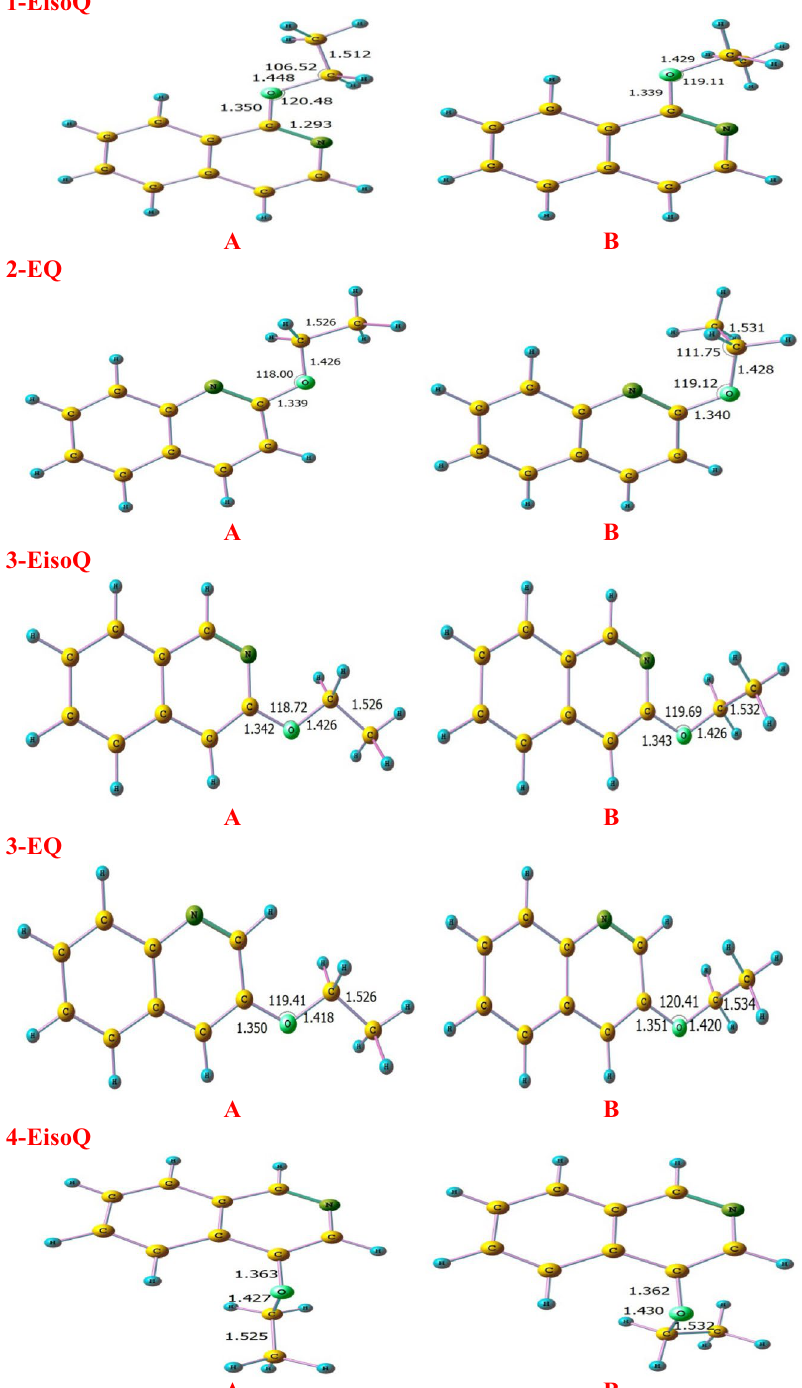
Figure 1. Optimized structures of different conformers ( A , B ) at the BMK/6–31+G(d,p) level of theory